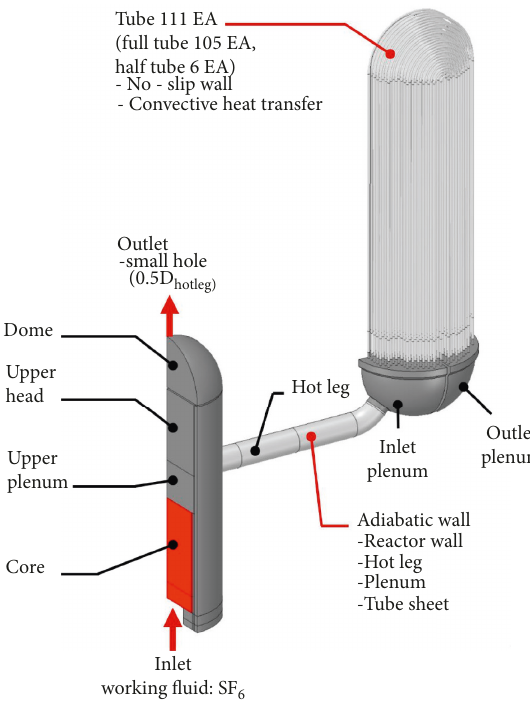
Figure 3: Boundary conditions.